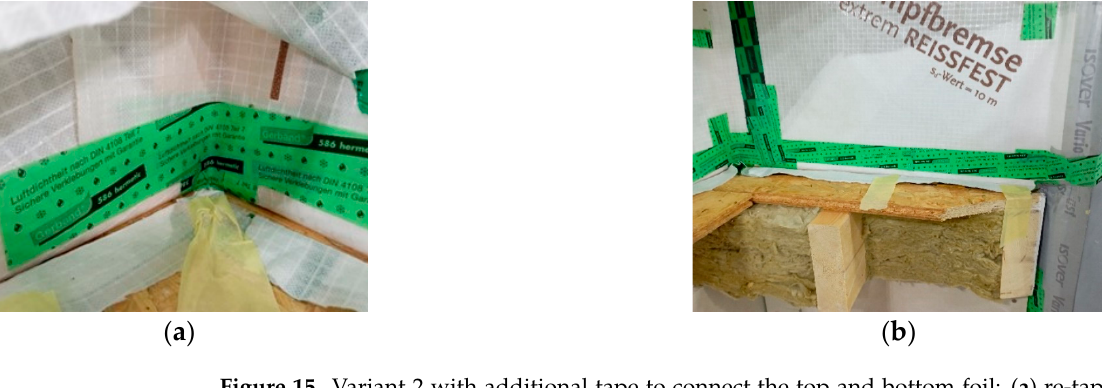
Figure 16. Linear regression graph for airtightness measurements of the 2nd variant, Q 50 = 2.503 m 3 /h, q 50 = 1.026 m 3 /(m 2 .h). Measurement deviations are higher when varying the temperature compared to the measurements by steady temperature, differing only in relative humidity (Table 3). That is foremost visible in the second variant at a 35 °C temperature in different relative humidity, where the deviation in q 50 is only 0.019 m 3 /(m 2 .h), caused by the fact that the relative humidity inertia is higher compared to the temperature inertia. Table 3 summarizes the measurements and their outcomes. Figure 17 shows each measurement’s air permeability values, a circle standing for variant 1 and a triangle for variant 2. The red color means that the relative humidity by the measurements was higher than 50%. In contrast, the green color means an Rh lower than 50%. The blue shows reference climatic conditions—20 °C and 50% Rh. For higher clarity, Figure 18 shows the results in histogram form, highlighting the coupled measurements for both first and second variants.